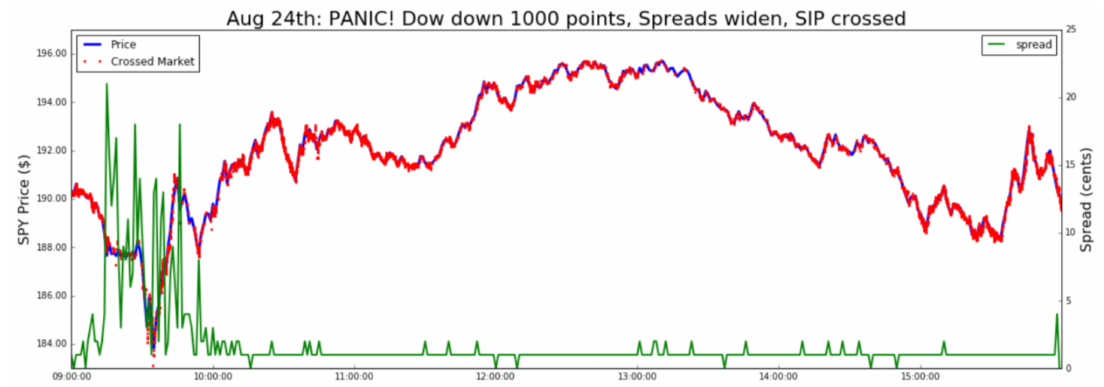
Figure 2. Crosses and Spreads in the SPY on 24 August 2015— “Manic Monday.”